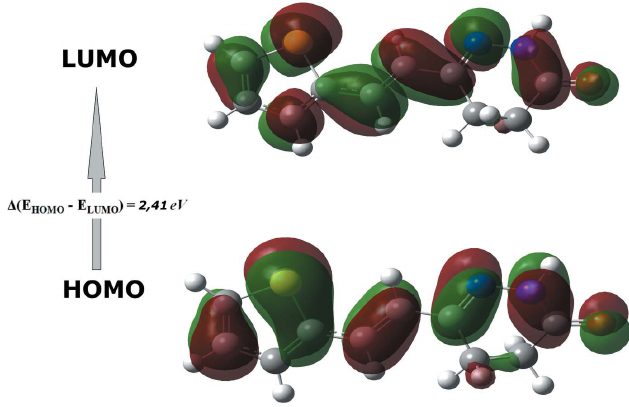
Figure 4 Two-dimensional fingerprint plots for the title compound, with a d norm view and the relative contributions of the atom pairs to the Hirshfeld surface.